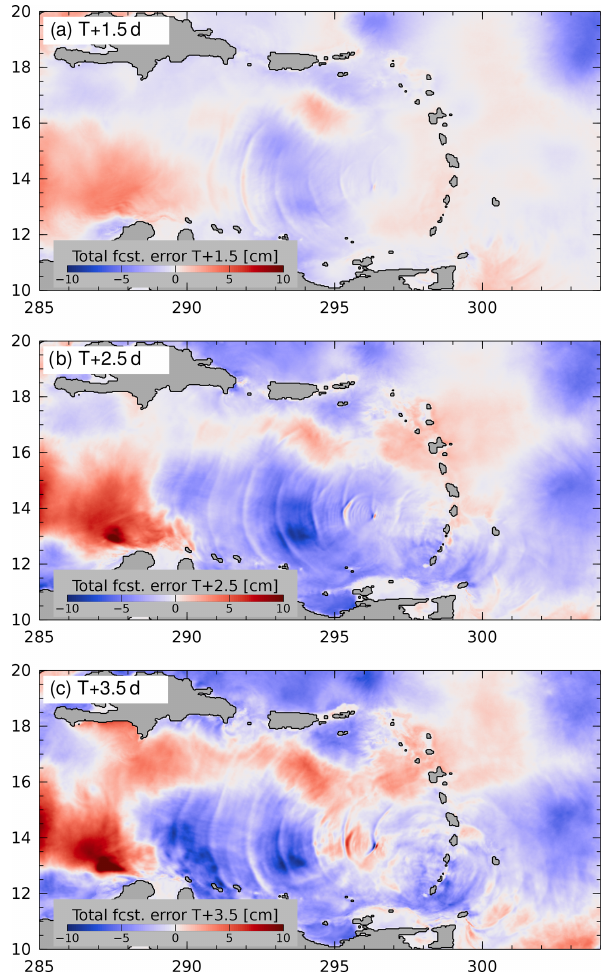
Figure 6. The steric height forecast error for different lead times for T n = 4 January 2013 at 12:00:00Z: (a) T n = T f + 1 . 5d, (b) T n = T f + 2 . 5d, and (c) T n = T f + 3 . 5d. Note that the color scale differs from previous figures; it was chosen to make the error growth visi- ble as a function of increasing forecast lead